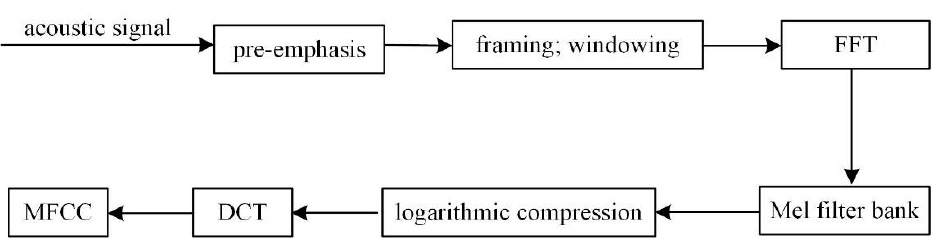
Figure 1. MFCC extraction process.